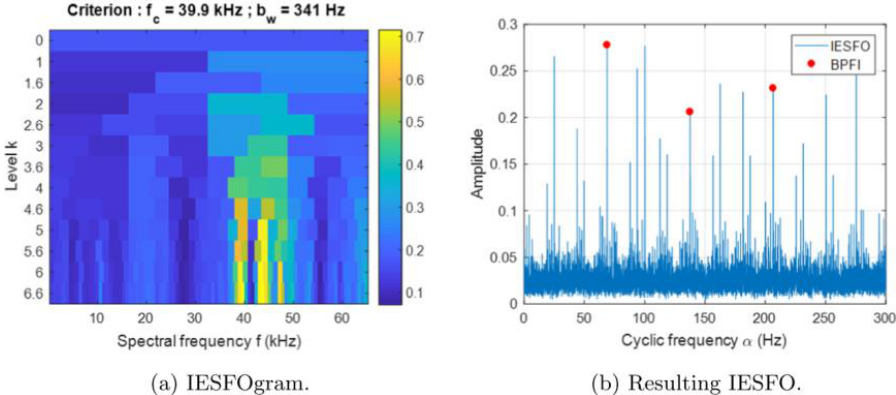
Figure 2. IESFO method applied to inner race fault with load 50 Nm. IESFO means improved envelope spectrum via feature optimization. IESFOgram means improved envelope spectrum via feature optimization-gram.